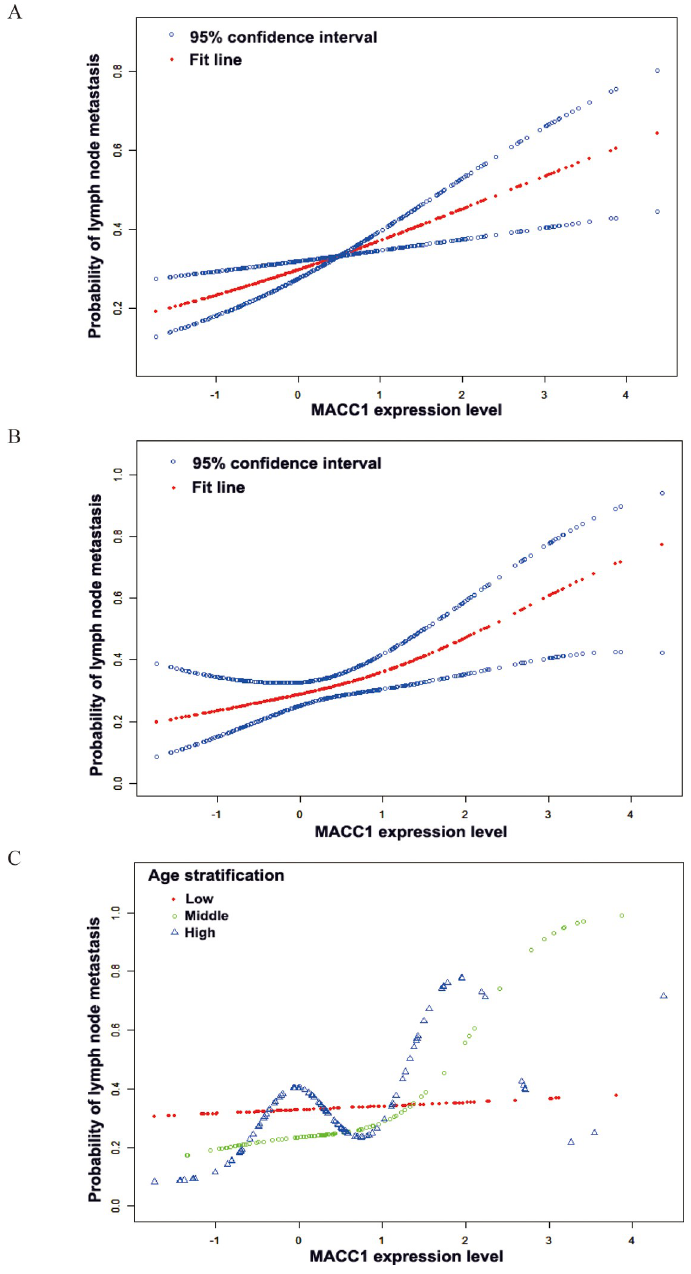
Fig 1. Relationship between MACC1 expression level and lymphatic metastasis. (A) A linear relationship between MACC1 expression level and lymphatic metastasis was observed. The blue circle lines on both sides represent 95% confidence interval and the red dot line represents the fitting curves. (B) A nonlinear relationship between MACC1 expression level and lymphatic metastasis was observed after adjusting all variables. The blue circle lines on both sides represent 95% confidence interval and the red dot line represents the fitting curves. (C) A nonlinear relationship between MACC1 expression level and lymphatic metastasis was observed after adjusting all variables in middle age group. Divide the age into three groups: The red dot line represents the lower age group, the green circle line represents the middle age group, and the blue triangle line represents the higher age group. In this figure, the horizontal ordinate represents the expression level of MACC1, and the longitudinal coordinate represents the probability of lymph node metastasis.